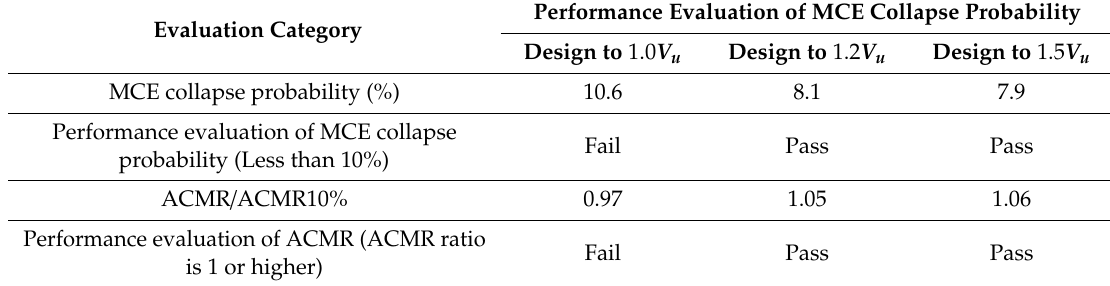
Table 12. Evaluation results for each design shear.